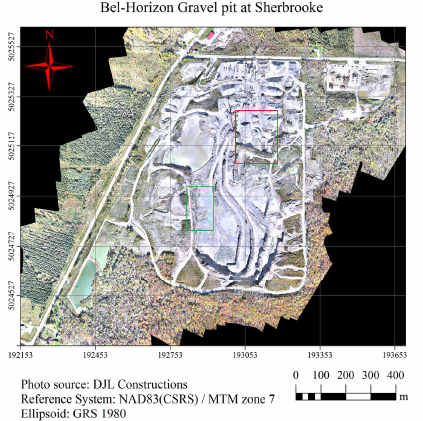
Figure 5. Study area, the open-pit mine located at Sherbrooke Planning the fieldwork is an important part of the project. The quality of the control and check data as well as the images depends highly on this stage. In order to plan the flight itself, there are several free software packages (e.g. Mission Planner).